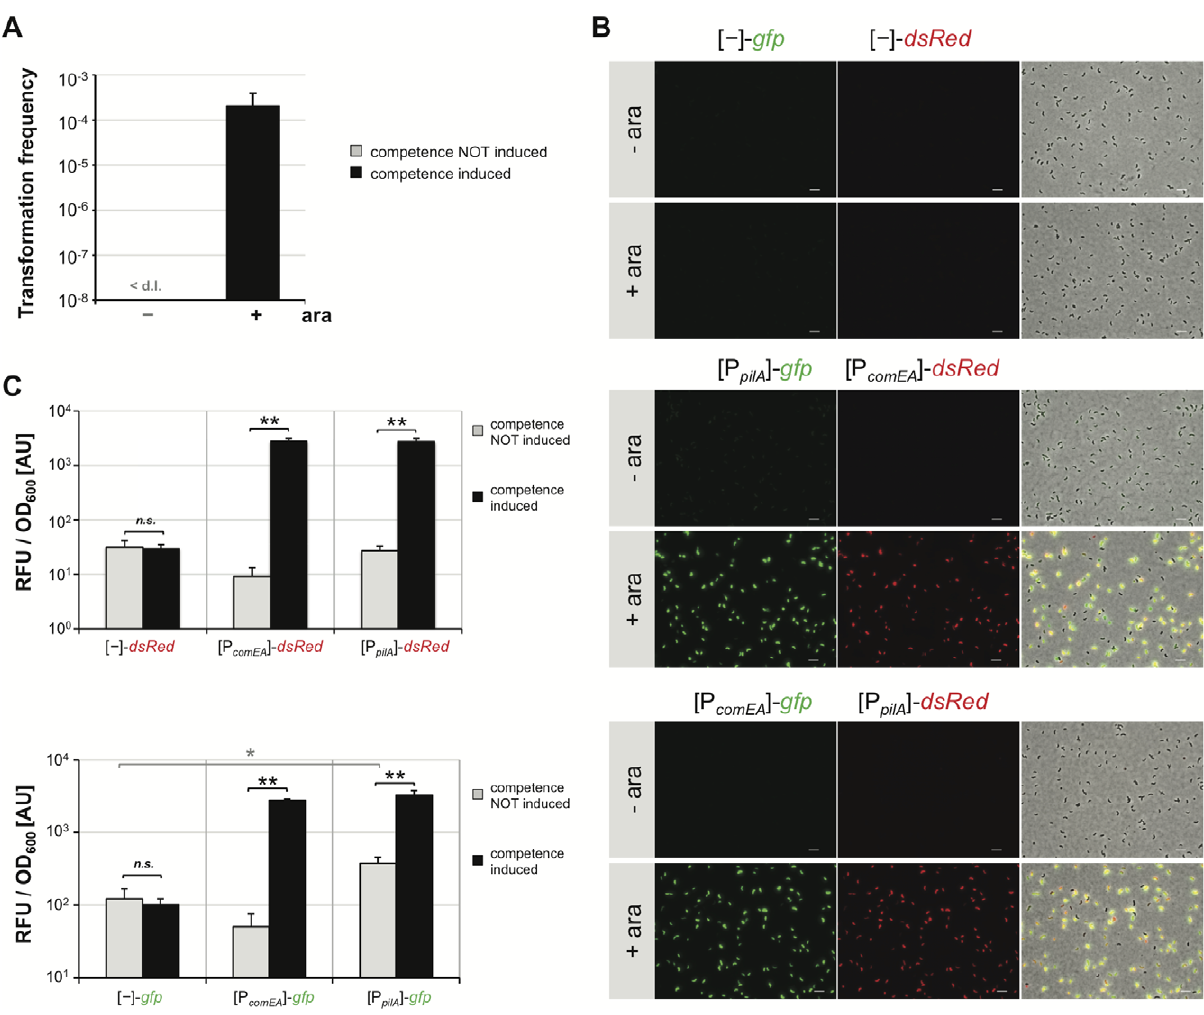
Figure 3. Artificial induction of natural transformation by expression of the competence regulatory gene tfoXincis . V. cholerae cells were grown in rich medium in the absence ( 2 ) or presence ( + ) of the artificial inducer arabinose (0.02%). Cells were either tested for natural transformability (panel A) or competence gene promoter activity based on FP reporters (panels B and C). Panel A: Transformation frequencies are given on the y-axis for competence-uninduced ( 2 ) and competence-induced ( + ) bacteria. , d.l.=below detection limit. Panel B and C: V. cholerae cells harboring the different transcriptional reporter fusions were grown without or with competence induction. Bacteria were either visualized by epifluorescence microscopy (panel B; image arrangements as in Figure 1; Scale bar=5 m m) or measured with respect to relative fluorescence units (RFU) and optical density at 600 nm (panel C). Panel C: RFU per OD 600 values are given on the y-axis. All experiments in Figure 3 were repeated at least three independent times. Error bars reflect standard deviations. Statistics were applied using the Student’s t test. * P , 0.05, ** P , 0.01, n.s.